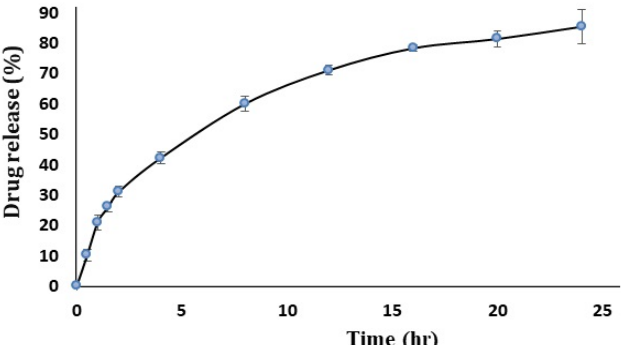
Figure 8. In vitro drug release profile of optimized ACR-PCL-NPs.